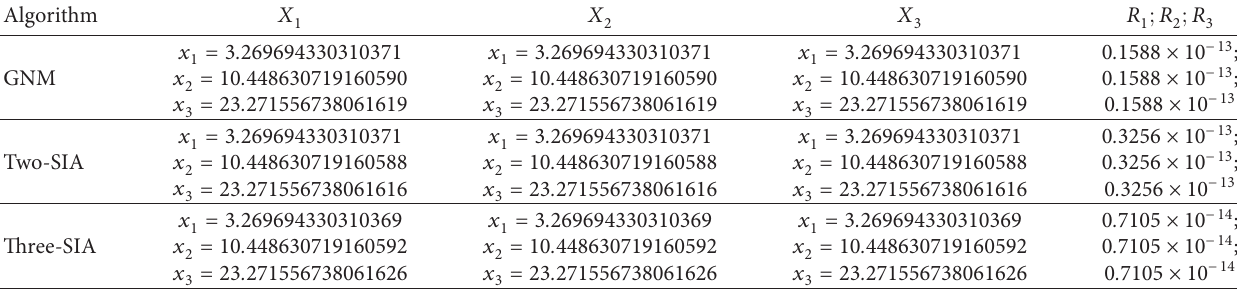
Table 2: The comparison of three-SIA, two-SIA, and GNM for Example 2.